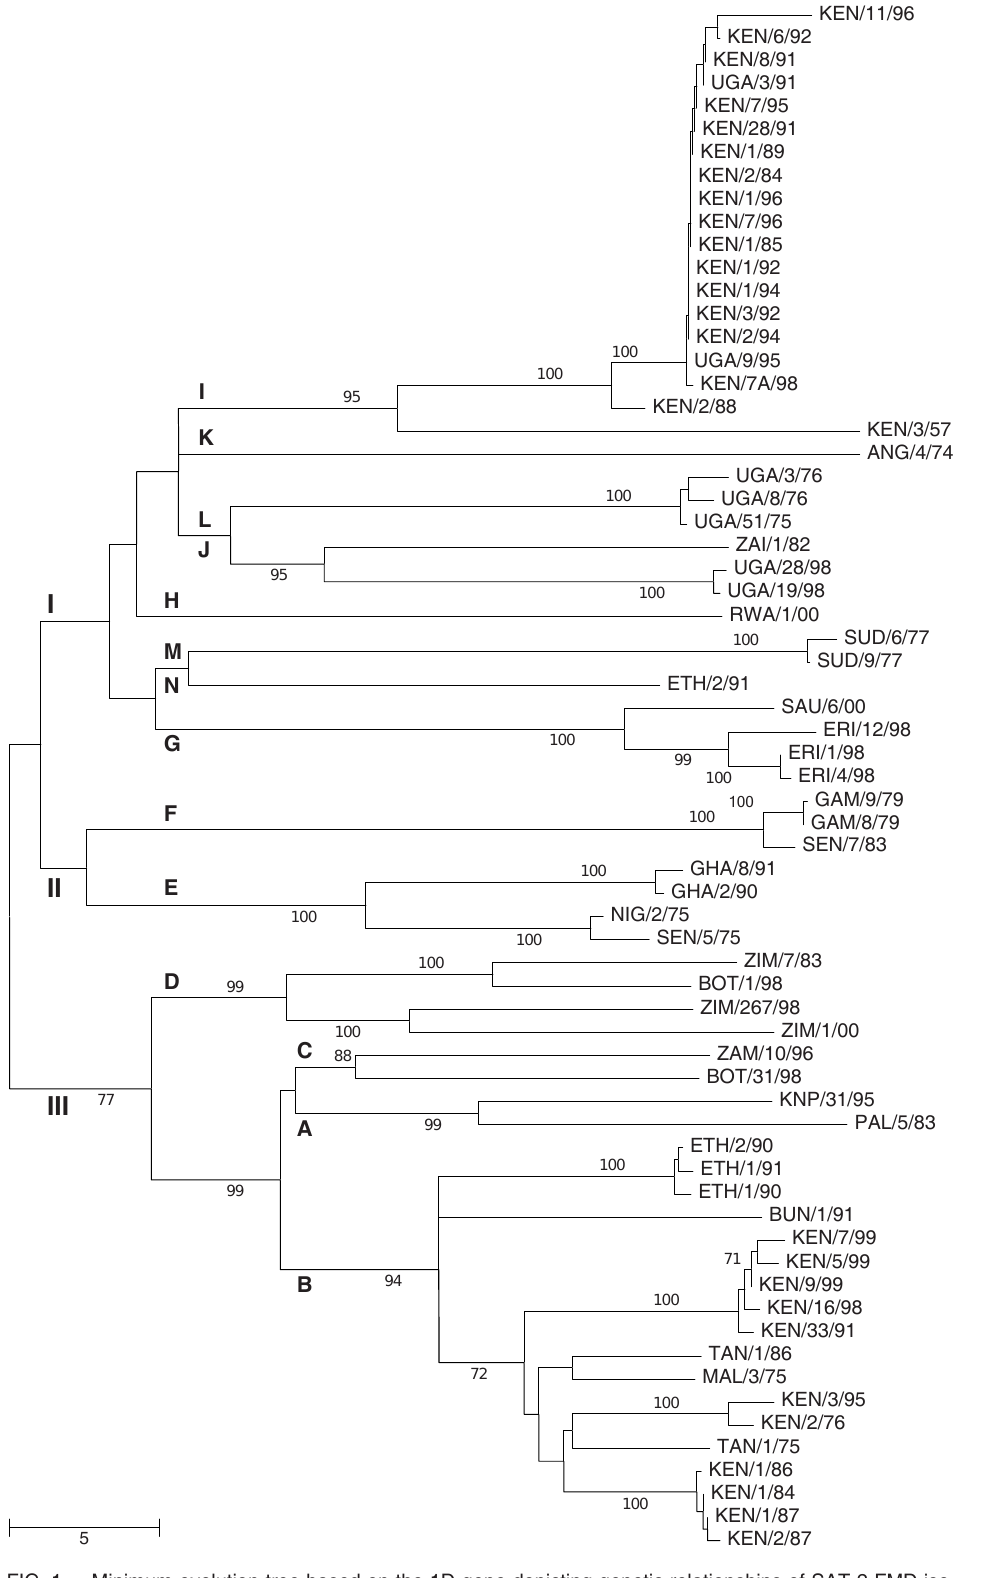
FIG. 1 Minimum evolution tree based on the 1D gene depicting genetic relationships of SAT-2 FMD iso- lates from sub-Saharan Africa. Bootstrap values were estimated based on 1 000 replications. I–III depict the major lineages, while A–N indicate